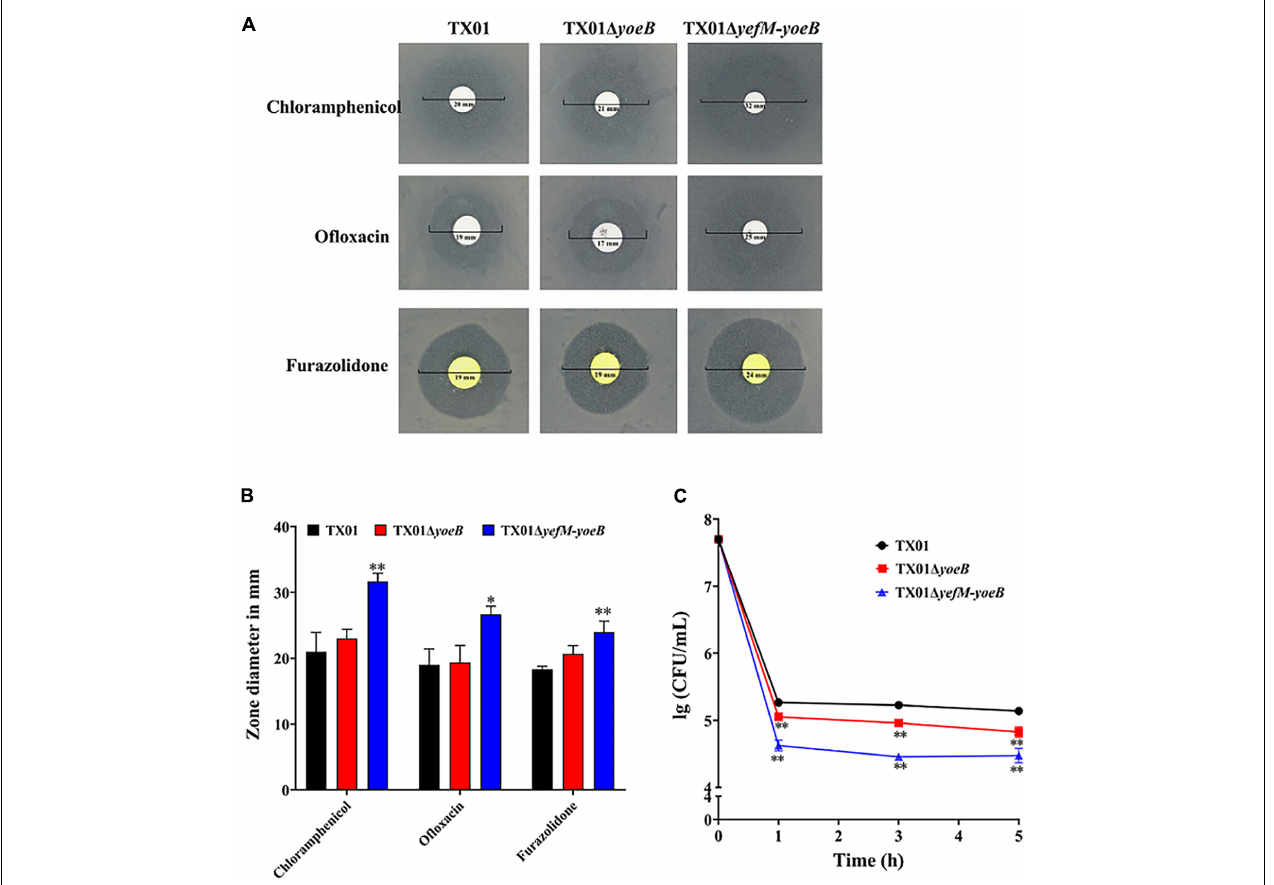
FIGURE 2 | Resistance of Edwardsiella piscicida to antibiotics and their ability to form persistent bacteria. (A) Drug sensitivity test of E. piscicida . Thirty drug sensitive papers were selected to determine the drug resistance of TX01, TX01 (cid:49) yoeB , TX01 (cid:49) yefM-yoeB by Kirby-Bauer. The three bacteria were sensitive to chloramphenicol, ofloxacin, and furazolidone, among which chloramphenicol was the most sensitive antibiotics. (B) The inhibition zone of chloramphenicol, ofloxacin, and furazolidone on TX01, TX01 (cid:49) yoeB , and TX01 (cid:49) yefM-yoeB . (C) Time-kill curves of different strains exposed to chloramphenicol. TX01, TX01 (cid:49) yoeB , TX01 (cid:49) yefM-yoeB were exposed to lethal concentration (240 µ g/mL) of chloramphenicol for 1, 3, and 5 h, then viable bacteria were determined by culturing on the LB agar plates. Data are presented as the means ± SEMs ( N = 3). N, the number of times the experiment was performed. ∗ P < 0.05; ∗∗ P <